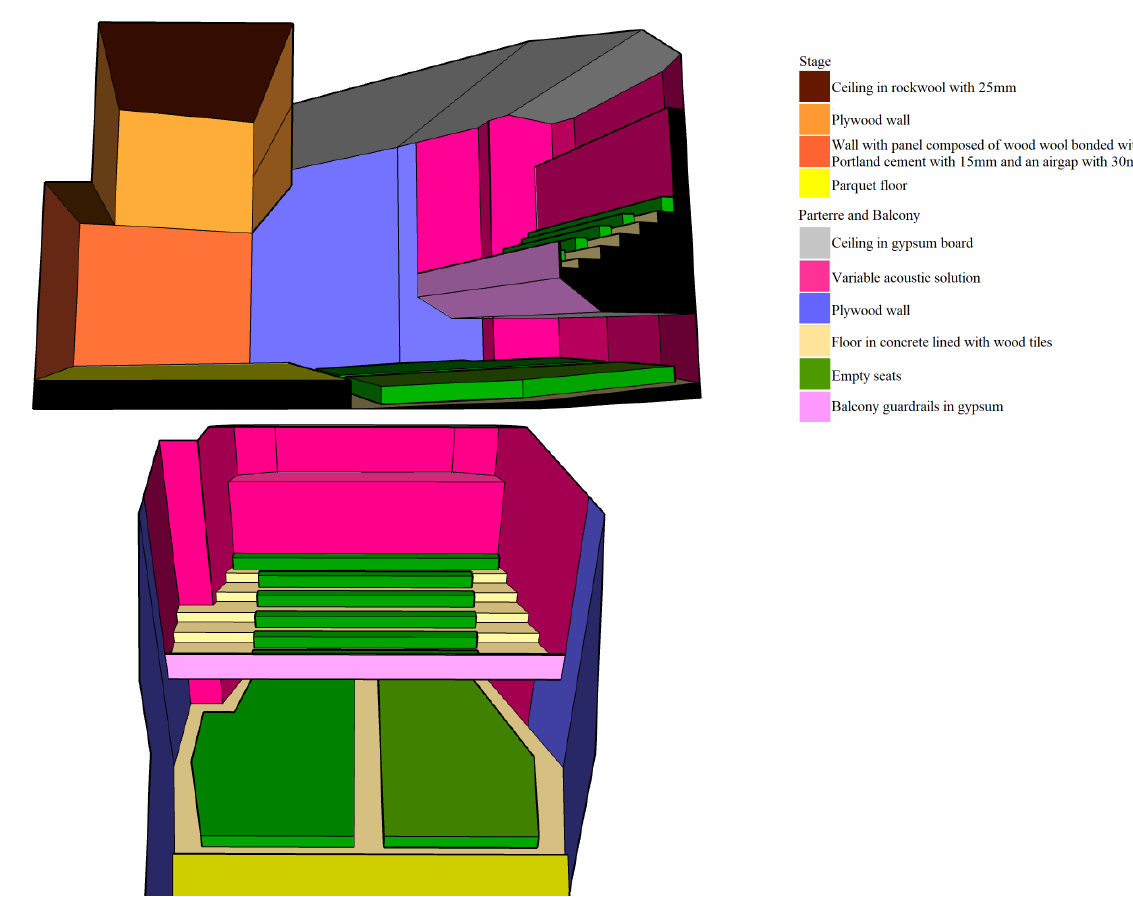
Figure 5. Geometry of the auditorium and distribution of the applied lining materials.